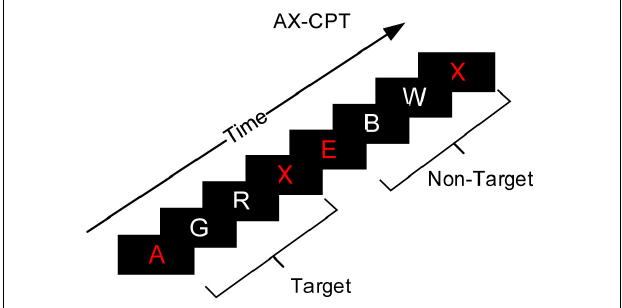
FIGURE 3 | Experiment instruction interface of the AX-CPT